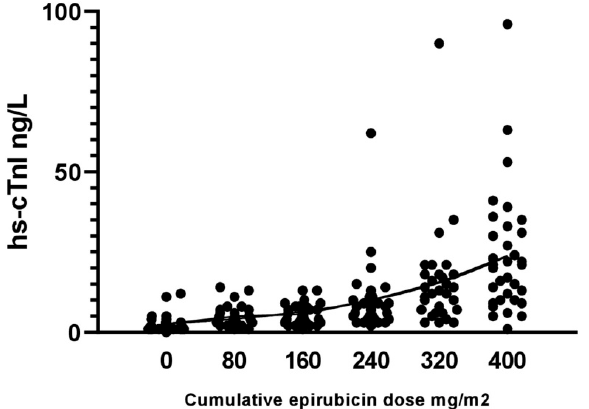
Figure 5. Troponin progressive increase as cumulative anthracycline doses increases with chemo- therapy advancement. From Tzolos et al.